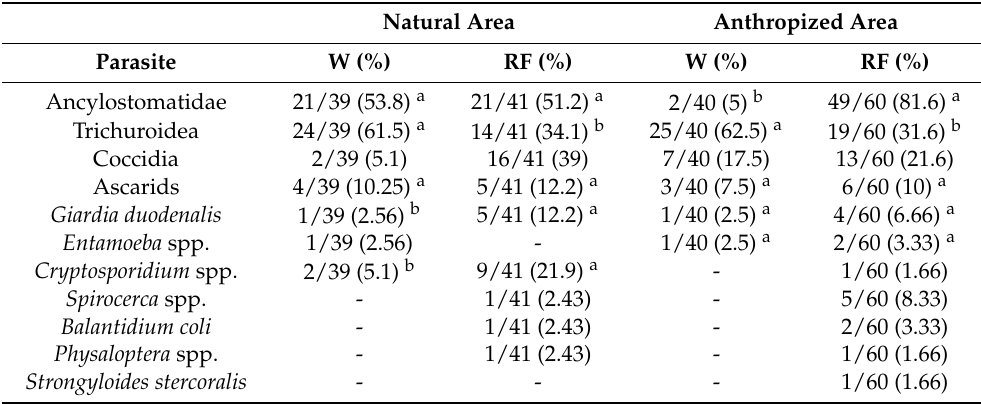
Table 3. Frequencies of gastrointestinal parasites identified in wolves (W) and red foxes (RF) in the natural and anthropized areas. Significant differences in the occurrence of each recorded parasite in each area between the two wild canid species are indicated with different superscript